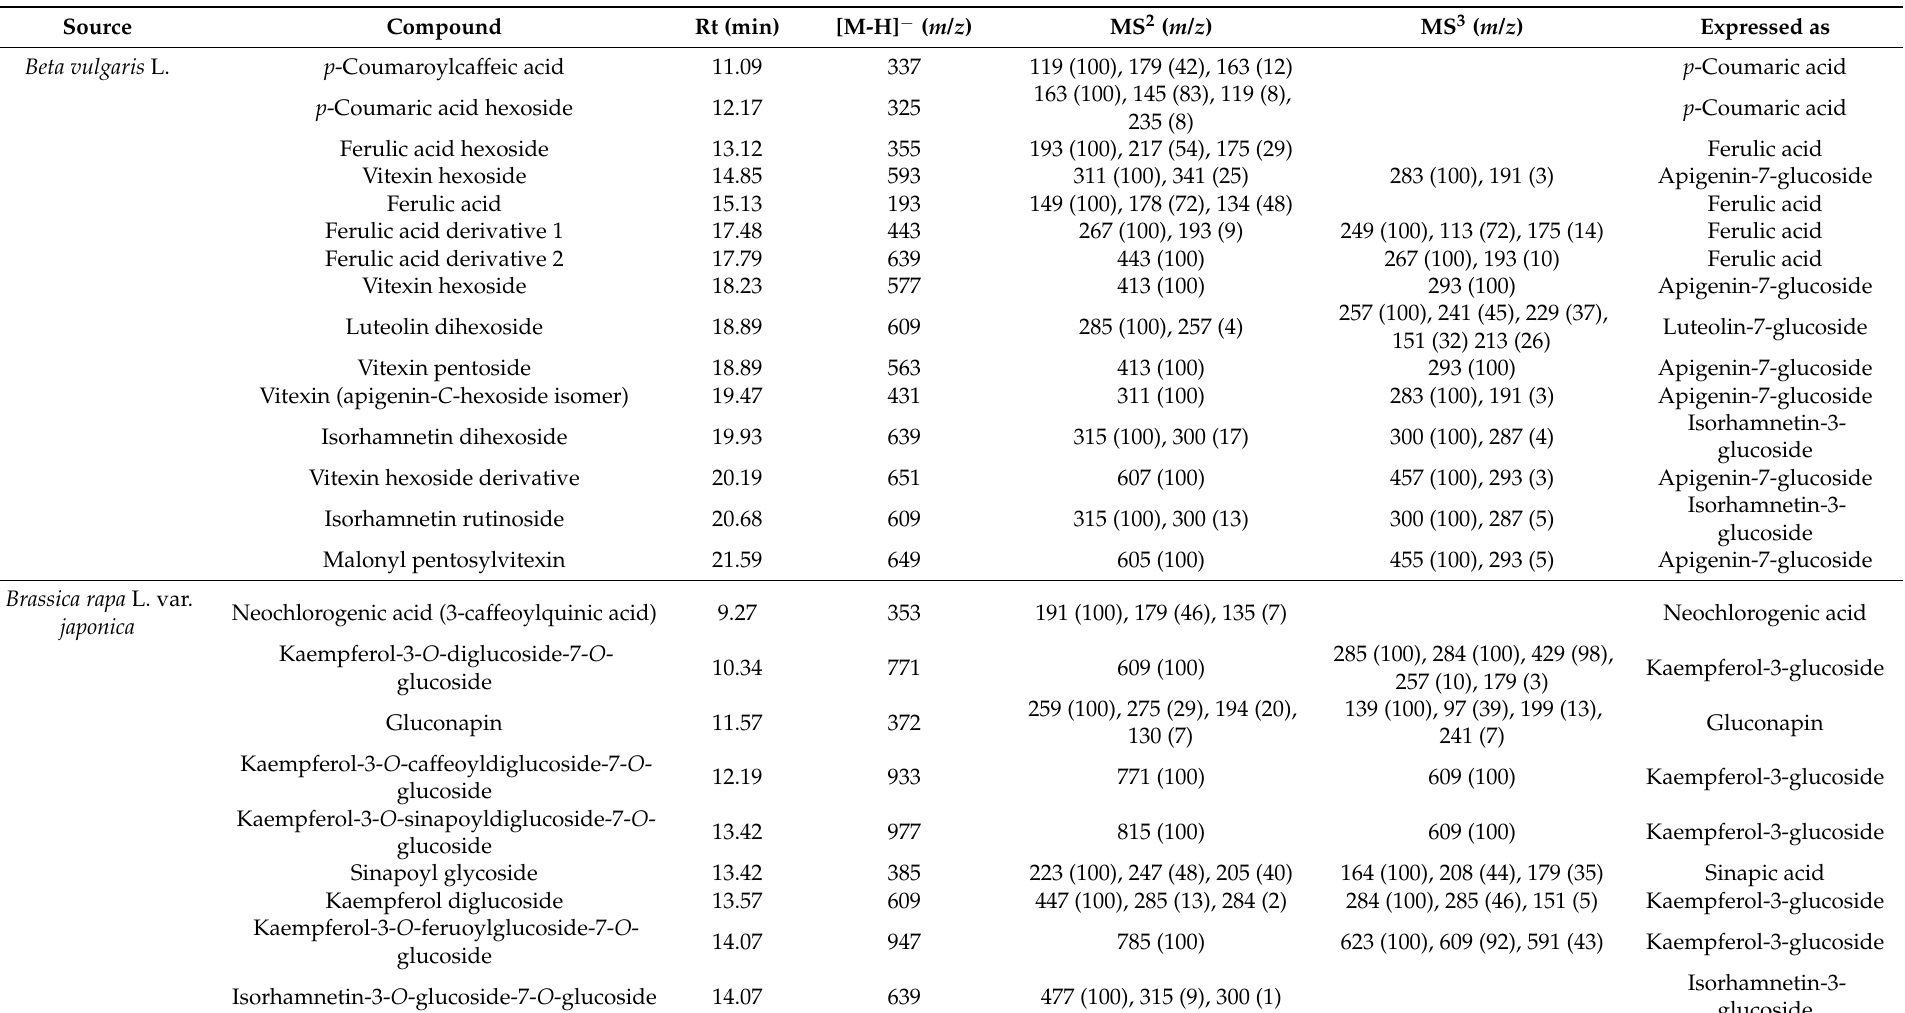
Table 1. Tentative identification of the 60 phenolic compounds from B. vulgaris , B. rapa var. japonica , L. sativa , and V. locusta , and the standards